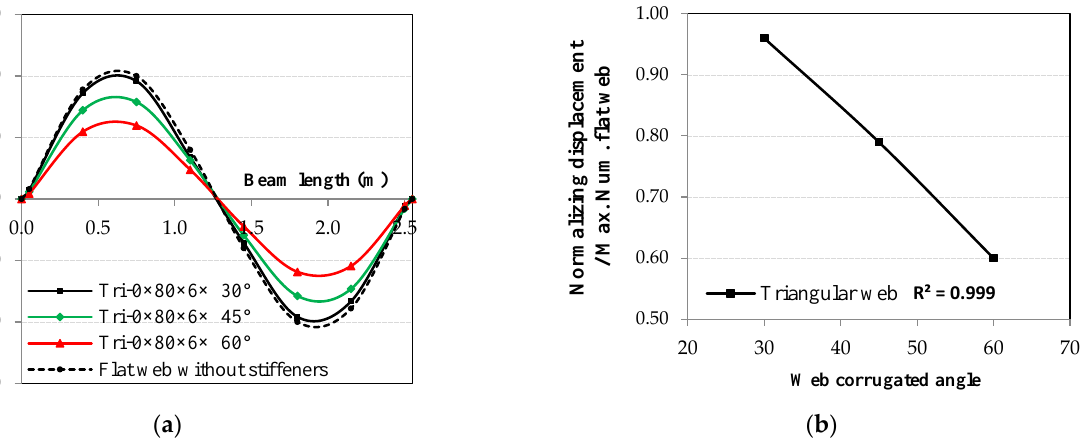
( b ) Figure 20. Corrugated angle effect on the relationship between normalized displacement and beam length for the 3rd mode shape: ( a ) triangular web and ( b ) angle effect at the 3rd mode shape.